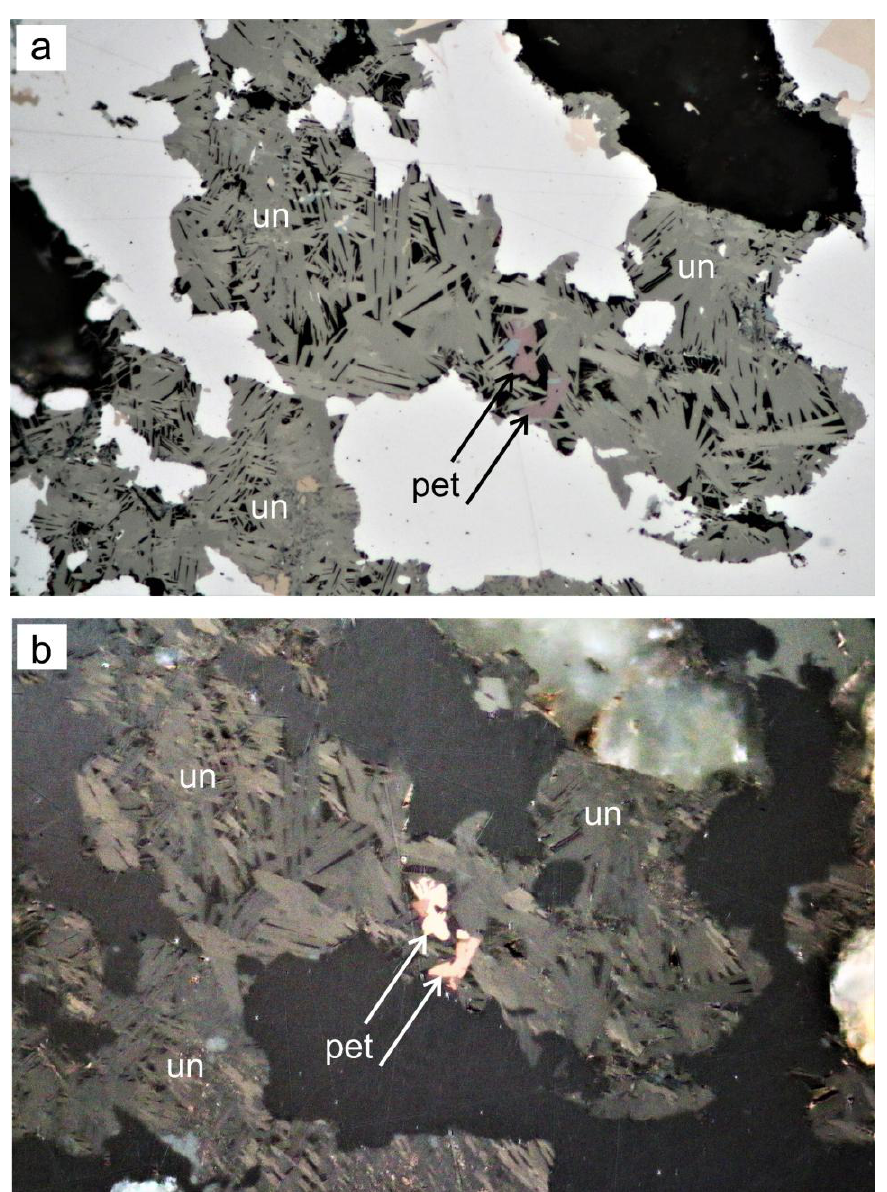
Figure 14. Reflected light images (each 200-μm-wide) of the unnamed Cu selenide (white mineral = clausthalite). ( a ) Plane polarized light; ( b ) crossed polarizers; un = unnamed Cu selenide, pet = end-member petříčekite. For further explanations see text.